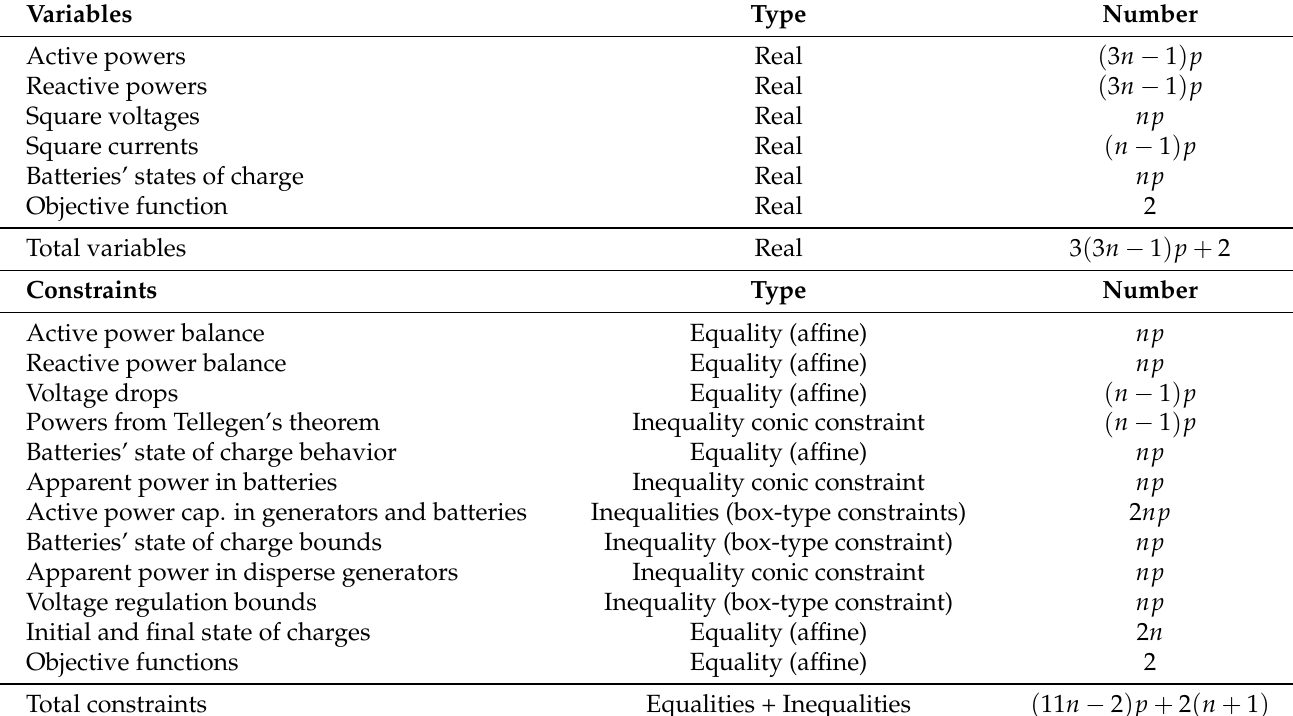
Table 1. Number of variables and constraints in the optimization model